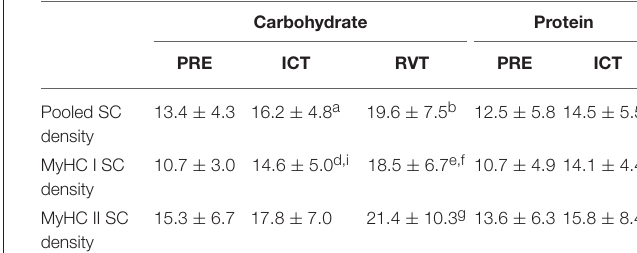
FIGURE 2 | Overlaid image of Pax7 + /DAPI + cells enclosed by laminin border. Image was captured at 20X magnification. (A) Laminin border of skeletal muscle fibers appearing purple with DAPI + cells appearing blue. (B) Pax7 + structures appearing yellow denoted with white arrows. (C) DAPI + cells appearing blue with white arrows denoting the myonuclei of Pax7 + /DAPI + cells. (D) Overlaid image with laminin, Pax7, and DAPI with white arrows denoting SCs that are Pax7 + /DAPI + and enclosed by a laminin border.